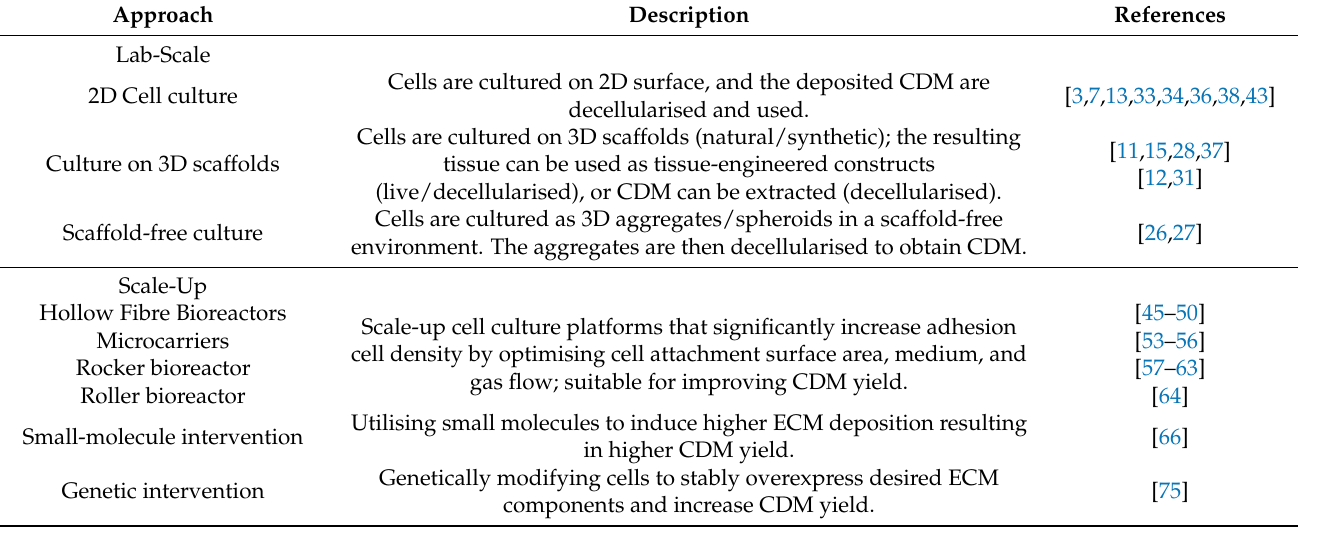
Table 2. Summary of approaches for CDM manufacturing.